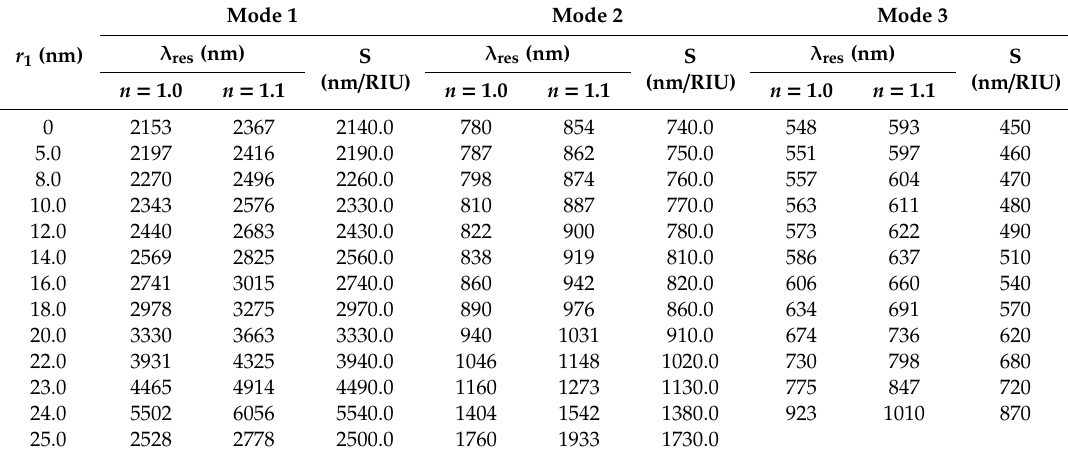
Table 1. Three modes and their corresponding RI sensitivity of the proposed structure under testing medium ( n = 1.0 and n = 1.1) versus di ff erent r